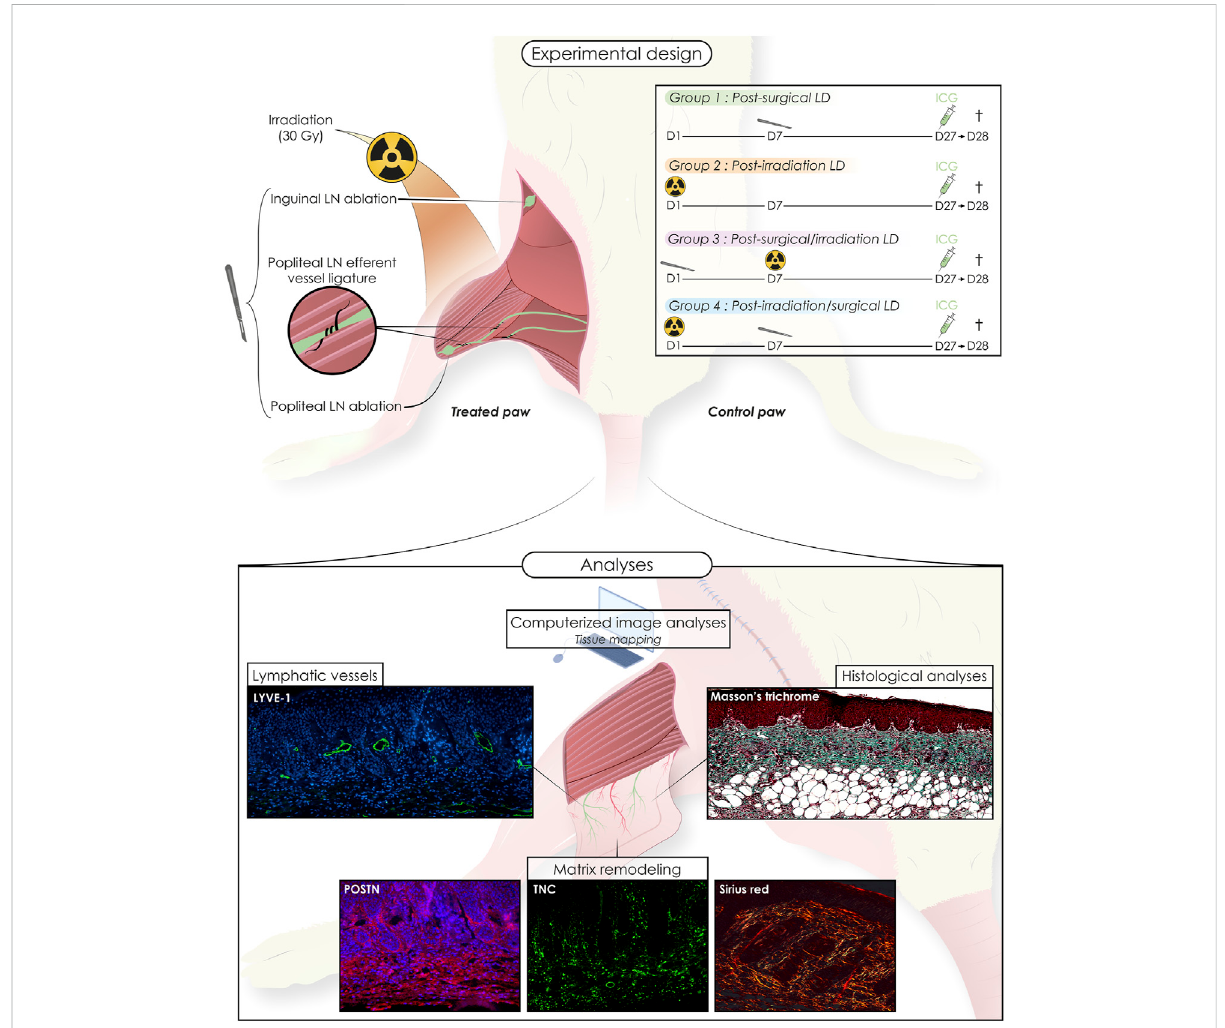
FIGURE 1 Schematic representation of the mice experimental model of secondary hind limb lymphedema (LD) induced by surgery and/or irradiation (alone or combined, in two sequences of intervention). Animals were separated into four groups: post-Surgery ( n = 8), post-Irradiation ( n = 7), post- Surgery/Irradiation ( n = 11), post Irradiation/Surgery ( n = 13). For each animal, the left hind limb was subjected to LD induction, while the right hind limb was used as control. The chronology of the interventions is detailed for each group as well as the different analyses